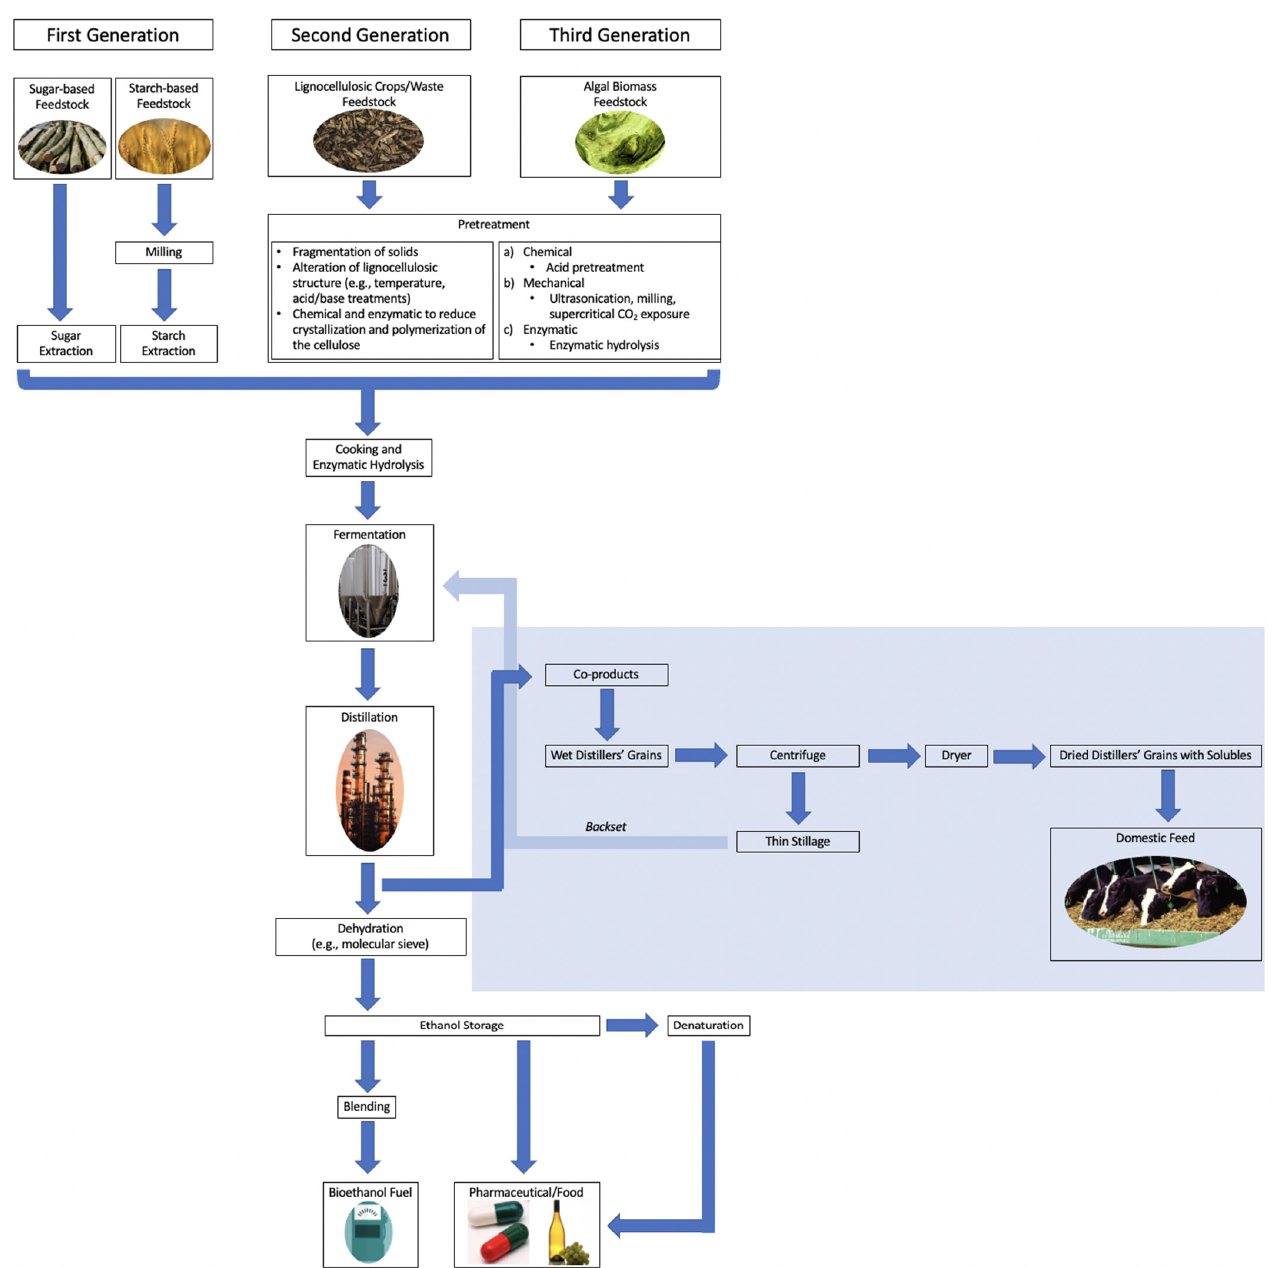
Figure 1. General flowchart of bioethanol production, providing a comparison of the pre-fermentation processing of feedstocks for the first three generations of bioethanol production. The blue highlighted area provides an example of a value-added process that can enhance the value of bioethanol production.